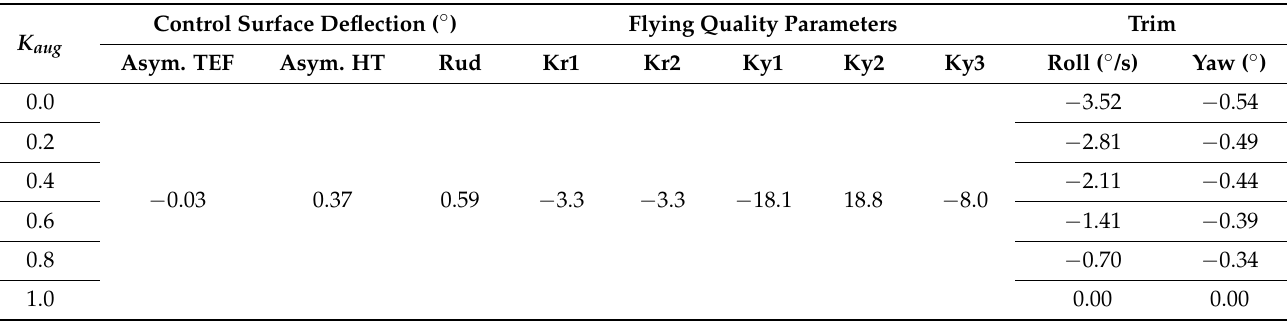
Table 1. Optimized flying quality parameters and trim data to 1-g wing level flight in asymmetric loading configuration (M0.8, 20 Kft altitude, 1 g level flight, asymmetric store configuration). K